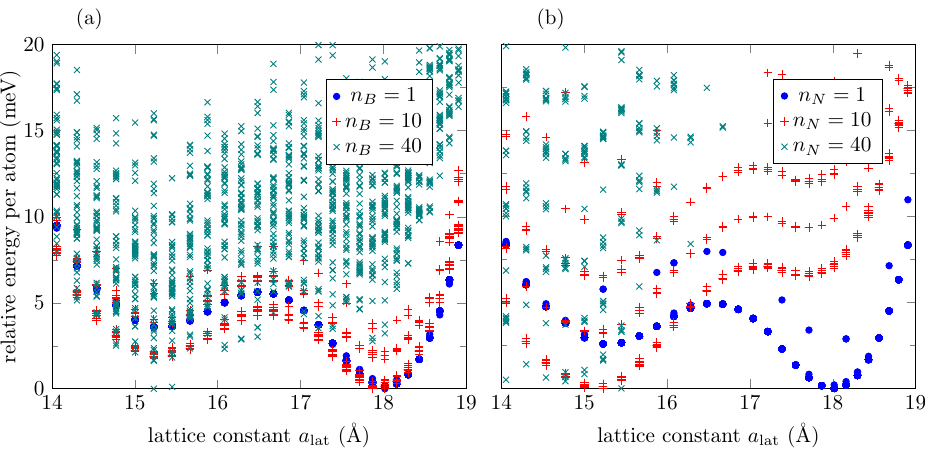
Figure 10. ( a ) Energy distribution, according to the ML potential, for a 401-AGONR where n B = 1,10,40 oxygen atoms out of 400 are replaced by boron atoms at random positions. ( b ) Same as ( a ) for nitrogen substitutions. Fifty samples are collected for each lattice constant and for each n B or n N